Question: Condense the content of this figure into a single sentence.
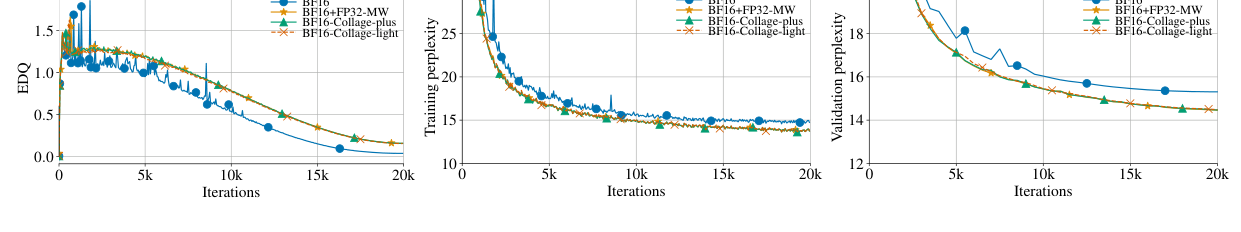
Answer: Pretrainnig progress for GPT 125M with settings described in Section 5.2 and global batch-size=2048, β2 = 0.99. Top-left: EDQ metric vs iterations, top-right: training perplexity vs iterations, and bottom: validation perplexity vs iterations for different precision strategy listed in Table 2. The proposed COLLAGE formations consistently match the FP32 master weights with much less memory footprint and faster training.